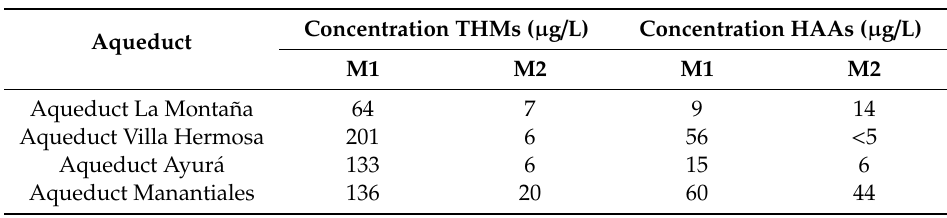
Table 2. Concentration of THMS and HAAs in drinking water from the city of Medell í n, samples collected at di ff erent points in the aqueduct network by the GDCON. Concentration THMs ( µ g / L) Concentration HAAs ( µ g / Aqueduct